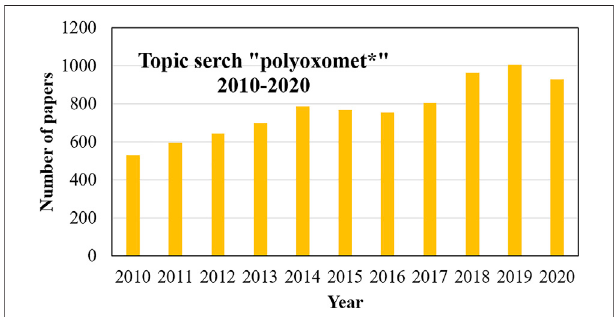
Frontiers in Chemistry |